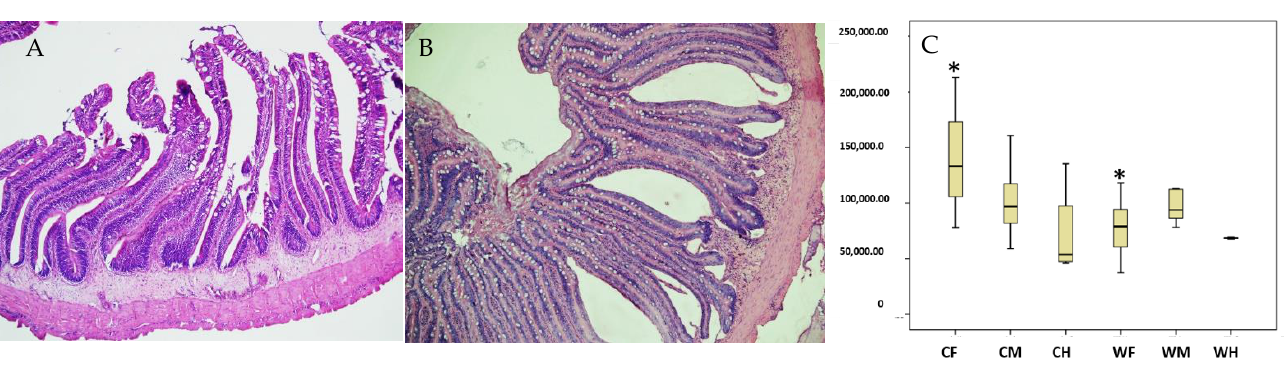
Figure 2. Histological structure the foregut of cultured ( A ) (H.E., bar = 500 µ m) and wild Hemibarbus maculatus ( B ) (H.E., bar = 500 µ m), and the absorption area ( C ) of gut segments in cultured and wild Hemibarbus maculatus. The width of foregut villus of the cultured was wider than the wild group. The absorption area of the cultured hindgut was larger than the wild group. Note: n = 30, the data were misrepresented by average ± standard deviation, * indicates that the data are significantly dif-ferent from those of cultured (wild) ( p < 0.05). CF: Cultured foregut; CM: Cultured midgut; CH: Cultured hindgut; WF: Wild foregut; WM: Wild midgut; WH: Wild hindgut. Table 4. Indexes of gut tract in Cultured and wild Hemibarbus maculatus.